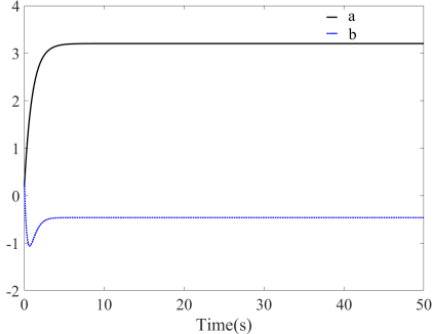
ˆ b (without disturbance,